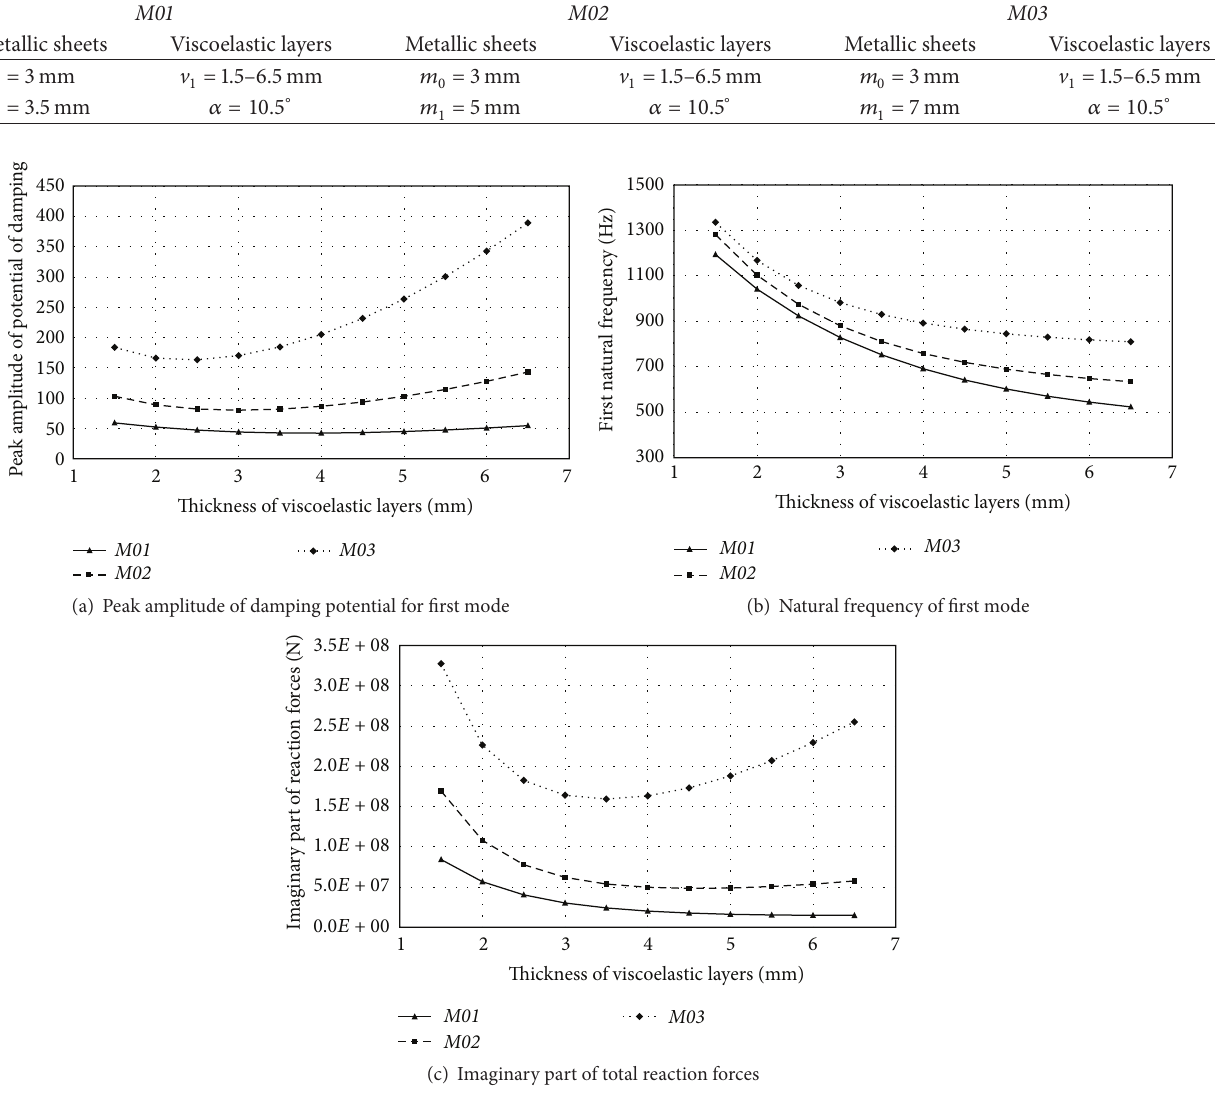
Figure 5: Analysis of damping potential for different thicknesses of the viscoelastic